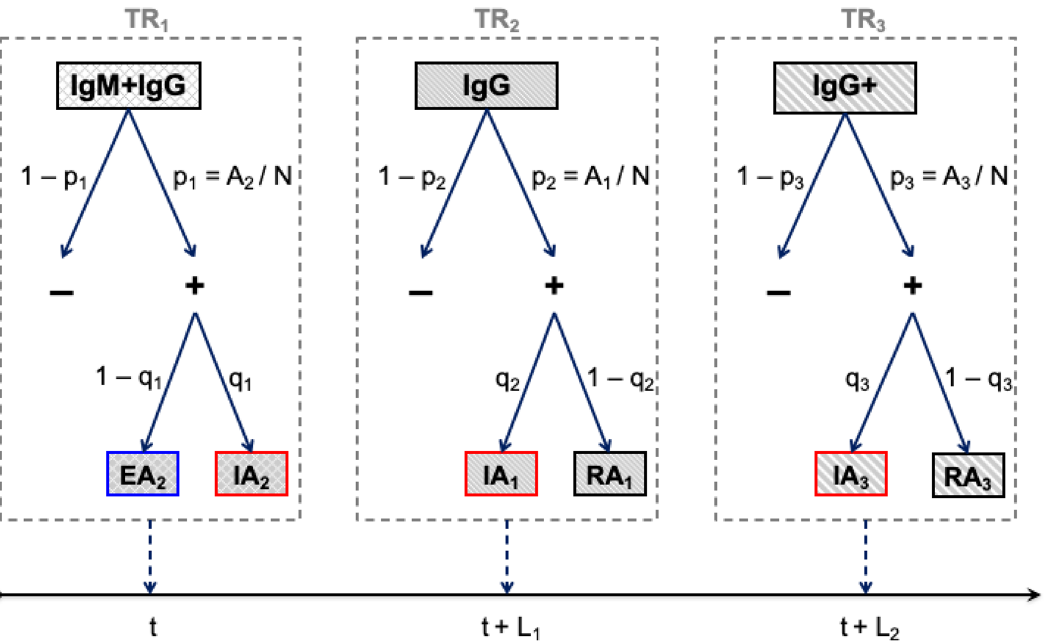
Figure 6. Results of a diagnostic test. TR i stands for test result. The prevalence p i corresponds to the true fraction of positive individuals carrying targeted antibodies and q i the fraction of them that are infected. L 1 and L 2 represent the lag times between associated antibody states of the